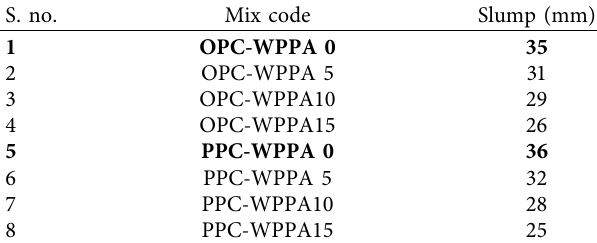
Table 10: Slump test results of OPC-WPPA and